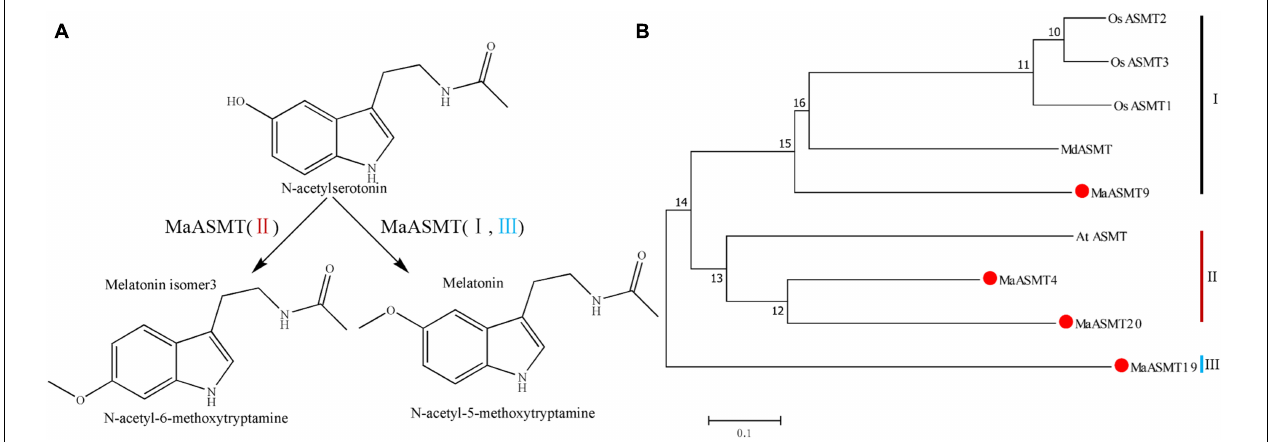
FIGURE 6 | The final step of the biosynthetic pathways of melatonin and its isomer and a phylogenetic tree of the ASMT family. (A) The final step of the biosynthetic pathways of melatonin and its isomer in “Dashi.” ASMT: N -acetylserotonin methyltransferase. (B) Phylogenetic tree of amino acid sequences of ASMT in “Dashi” and other plants. The phylogenetic tree was generated with the neighbor-joining method using MEGA5 software. ASMTs were separated into three groups: class I (black), II (red) and III (blue). The function of ASMT genes has been characterized. Information of ASMT genes was listed in Supplementary Table 5